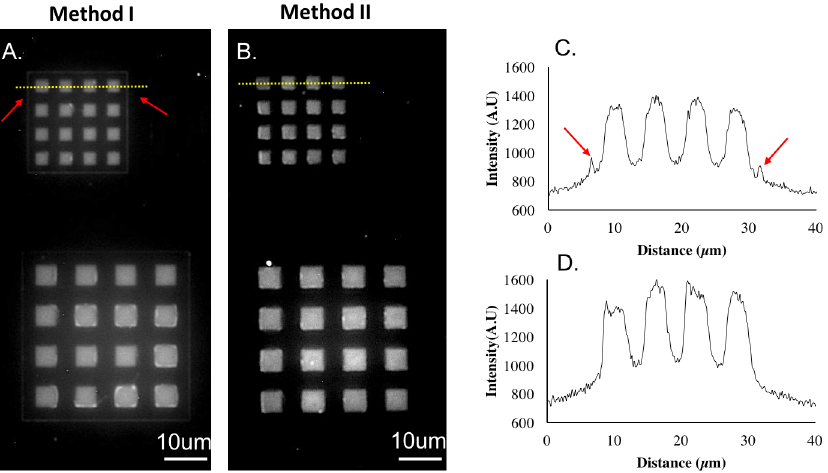
Fig 3. Sidewall coverage depends on how conformal the deposition process is. Biotin microarrays were generated by either Method 1 (A) or Method 2 (B) illustrated in Fig 1. Strep-647 was then used to label biotinylated surfaces. Sidewall conjugation is shown in A) pointed out by red arrows but not in B) due to the higher conformal deposition of LPCVD (B) vs. E-beam evaporation (A). Intensity profiles along the yellow dash lines in A) and B), are shown in C) and D) respectively. Red arrow in C) correspond to the side wall intensity labeled by the red arrows in A). Any misalignment between conjugated regions and wells was too small ( < 100nm) to measure with our fluorescent